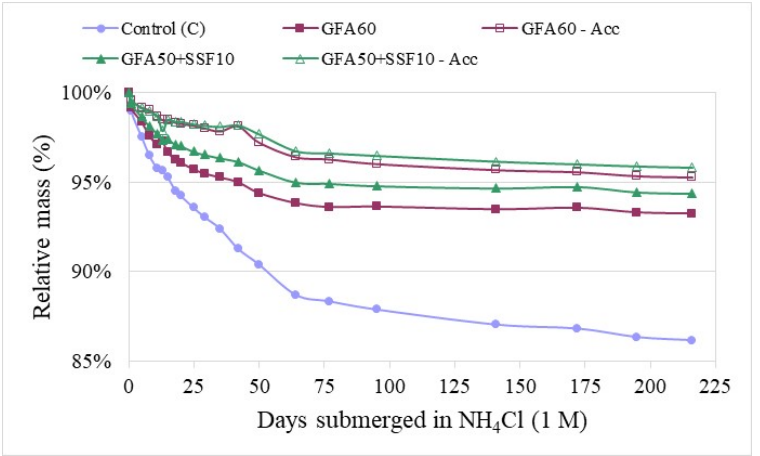
Figure 11. Mass variation for the GRC composites immersed in a 1 molar (1 M) NH 4 Cl solution.